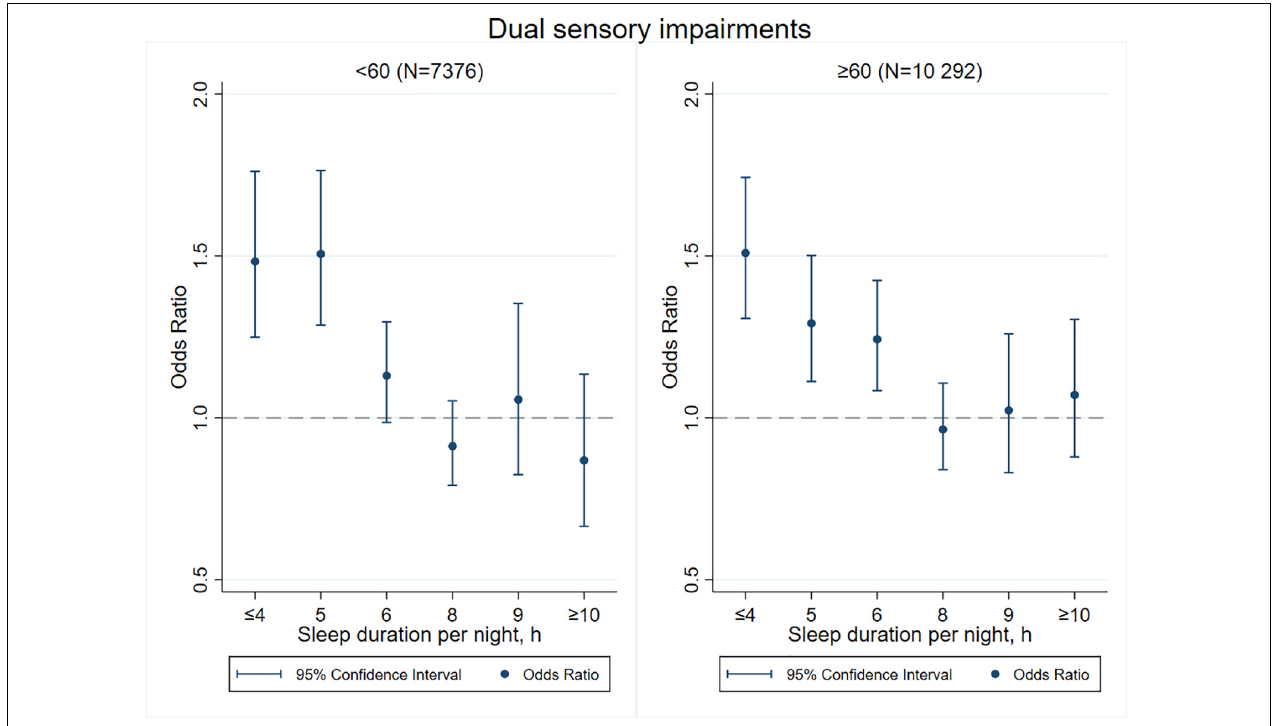
FIGURE 8 | Age-specific effect of sleep duration on dual sensory impairments.